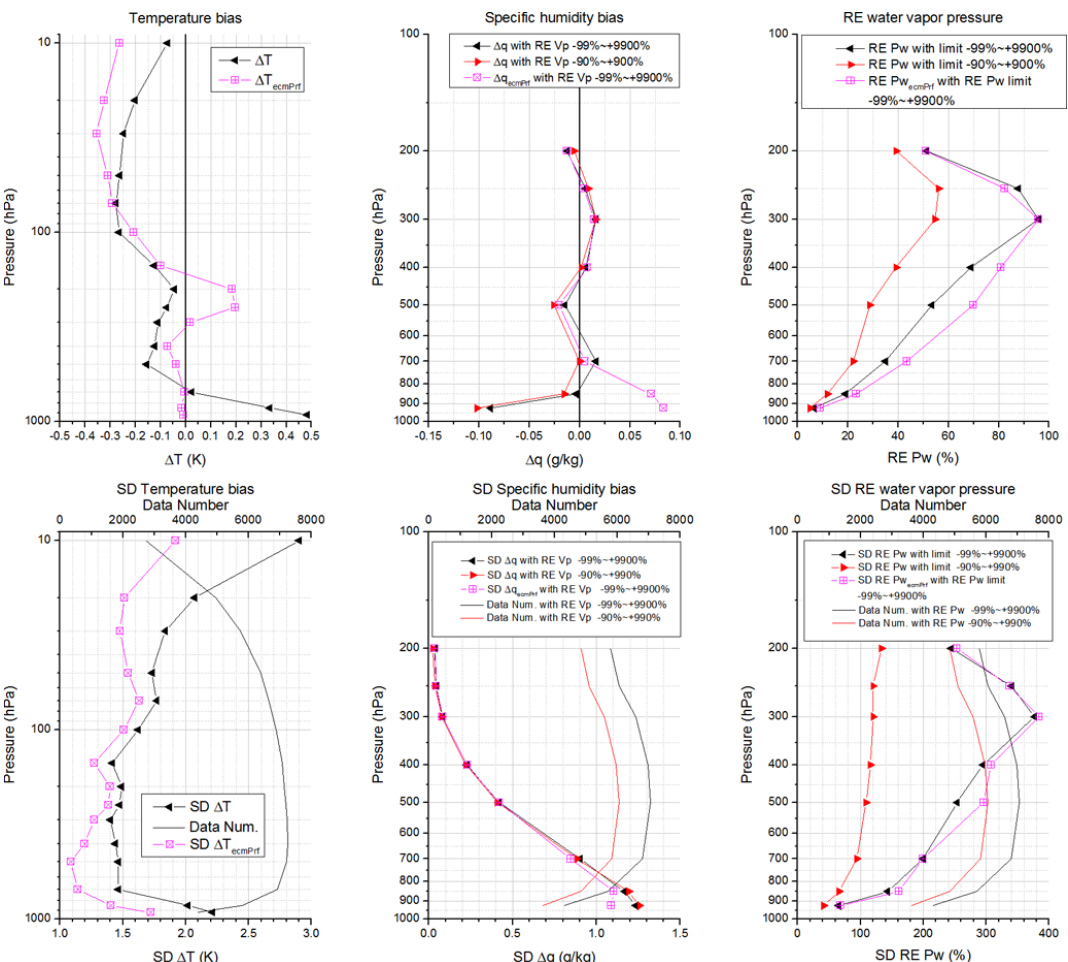
Fig. 2. Comparison of mean temperature bias, mean specific humidity bias, relative error of water vapor pressure, and their SDs. The purple curves show the results of the background ecmPrf, curves without symbols show the number of data